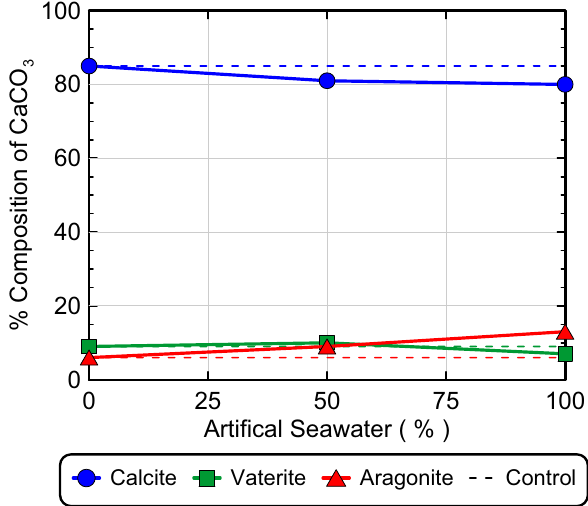
Figure 2. Relative CaCO 3 mineral content percentages for 0%, 50%, and 100% ASW experiments determined from S-Q analysis of XRD diffraction